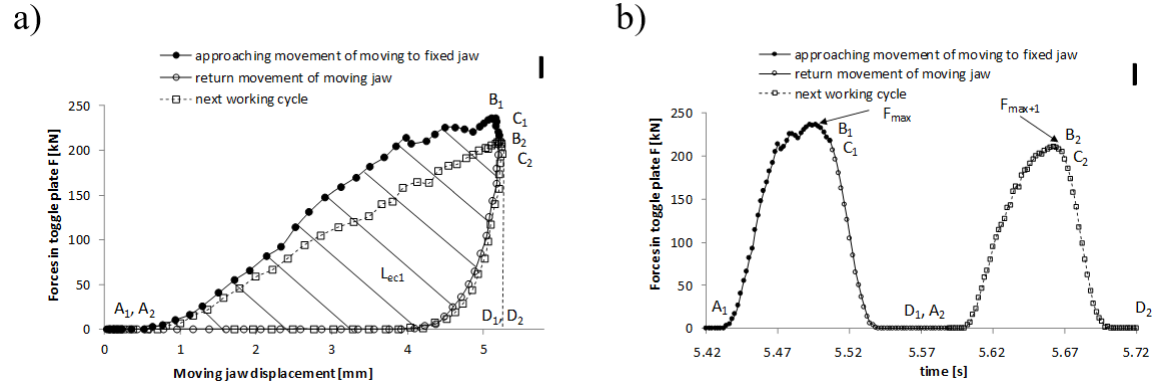
Figure 14: The two exemplary operation cycles of sandstone crushing by flat plates a) force vs. displacement diagram b) force vs. time diagram